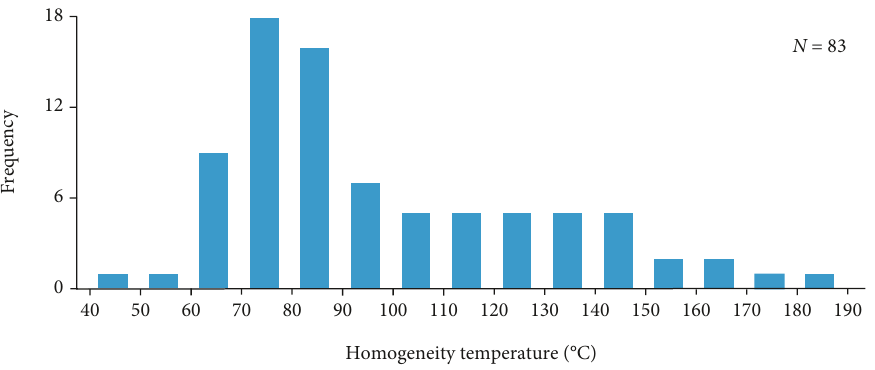
Figure 15: Homogeneous temperature distribution characteristics of primary brine inclusions in Lucaogou Formation, Jimsar